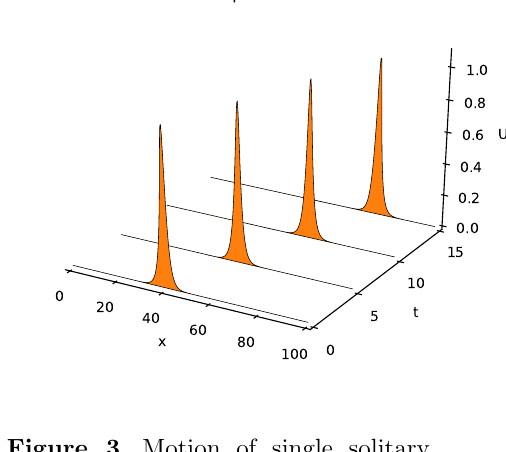
Figure 3. Motion of single solitary wave at t = 0 , 5 , 10 , 15 for N = 400 , ∆ t = 0 . 05 and p = 4.